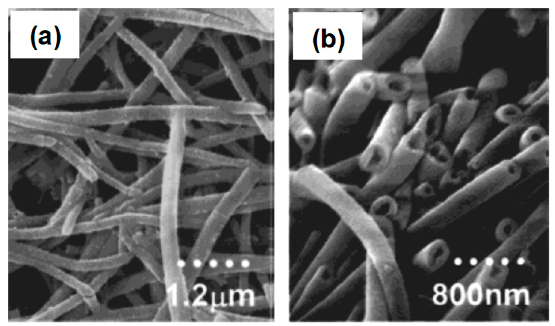
Figure 7. SEM images of the samples prepared under basic conditions: ( a ) dried sample from 30 ( b ) calcined sample. Reproduced with permission from Reference [80].